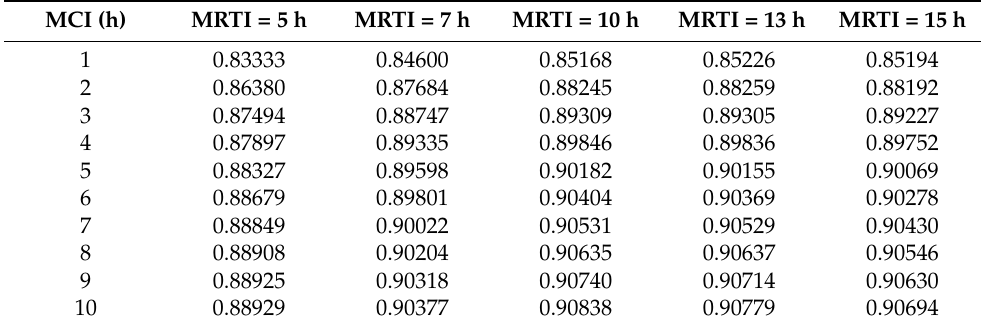
Table 6. Steady-state system availability (with human-error-related system failures). Note: MCI, mean checkpoint interval; MRTI, mean rejuvenation-trigger